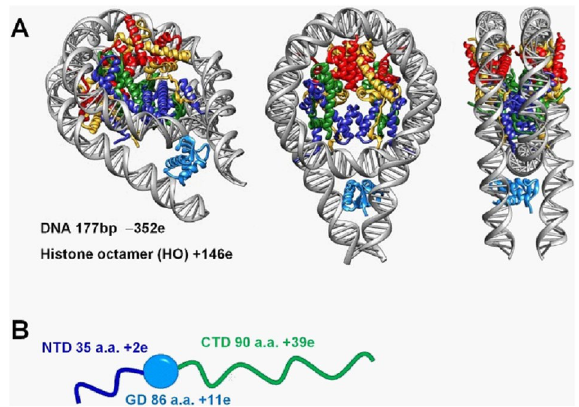
Figure 1. ( A ) 177 bp chromatosome, as a complex of the 177 bp nucleosome and linker histone H1. Three different views of the chromatosome are shown. The molecular structure was built using the crystal structure of the 197 bp chromatosome (5NL0.pdb 30 ) by cutting 10 bp from each DNA end. A significant part of the unstructured histone tails and N-(NTD) and C-terminal (CTD) domains of the H1 are missing from the crystal structure. DNA is coloured grey, the globular domain of the H1 is light blue, core histones are coloured yellow (H2A), red (H2B) blue (H3), and green (H4). Structures were visualised using CHIMERA 83,84,94 (www.rbvi.ucsf. edu/chime ra/). ( B ). Schematic presentation of the H1 domain structure comprised by a central globular domain (light blue) and flexible N-(blue) and C-termini (green). Net charges of the chromatosome components and H1 domains are indicated. Microsoft PowerPoint 2016 (www.micro soft.com) was used to draw the